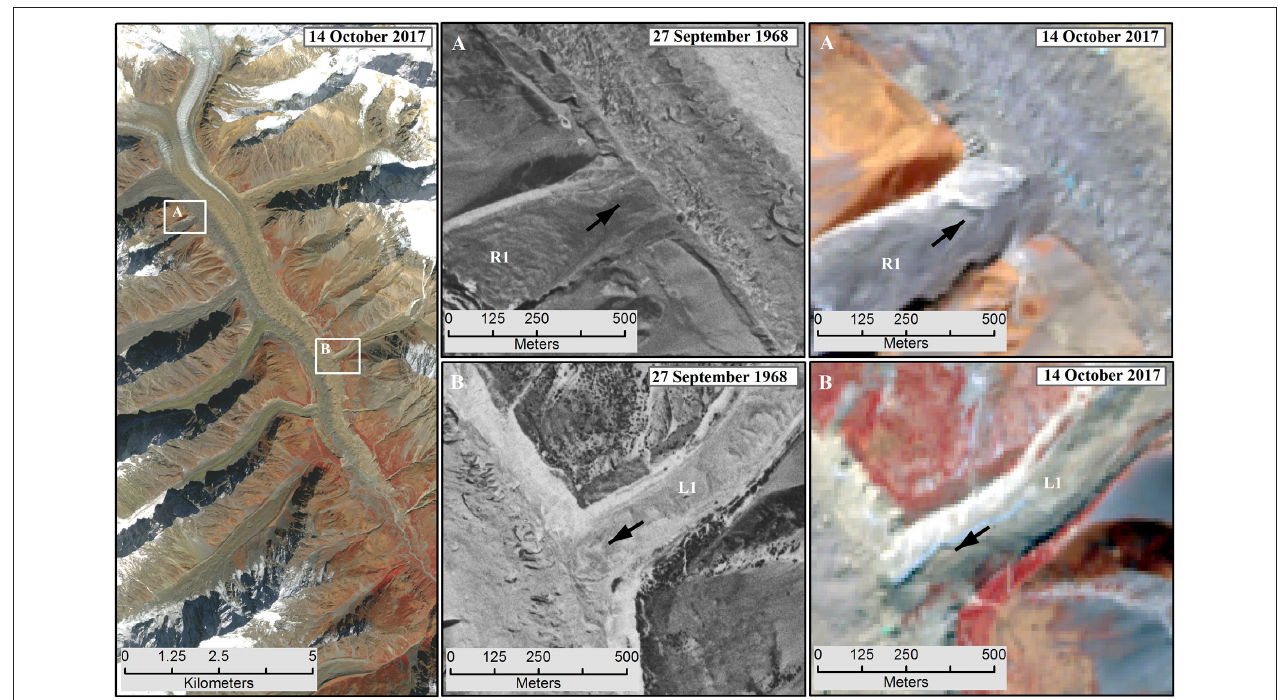
FIGURE 3 | Detachment of the tributary glaciers from the Milam glacier. White boxes on the Sentinel 2 image (14 October, 2017) show the locations of detached tributary glaciers from the main valley glacier. (A,B) Show the zoomed sections of tributary glaciers R1 and L1 on the Corona (1968) and Sentinel 2 image (2017),